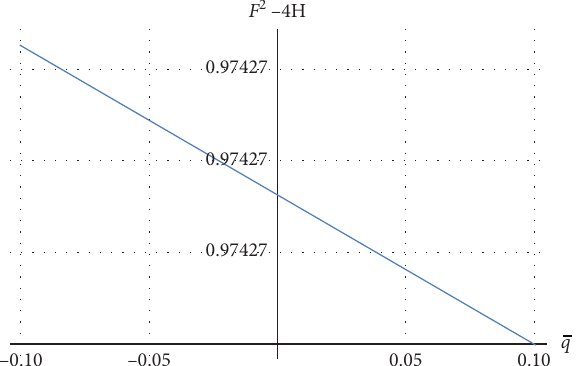
Figure 9: Condition (49), H > 0 is satisfied for − 0 . 1 ≤ q ≤ 0 . 1. Table 1: The Eigen values for equation (44).